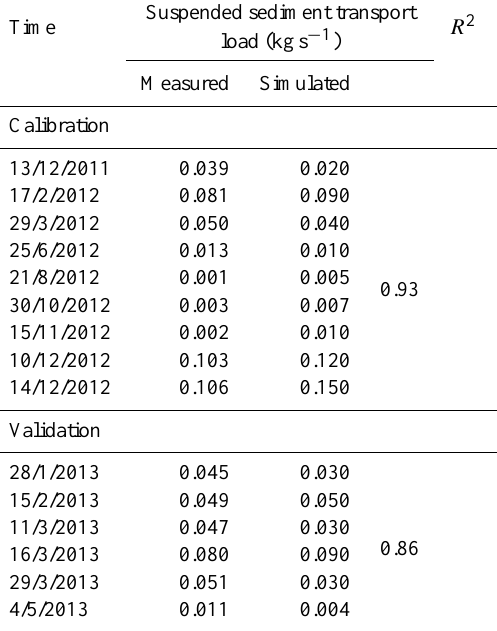
Table 2. Comparison of the AD submodel output and field measure- ments of the suspended sediment transport load for the calibration and validation